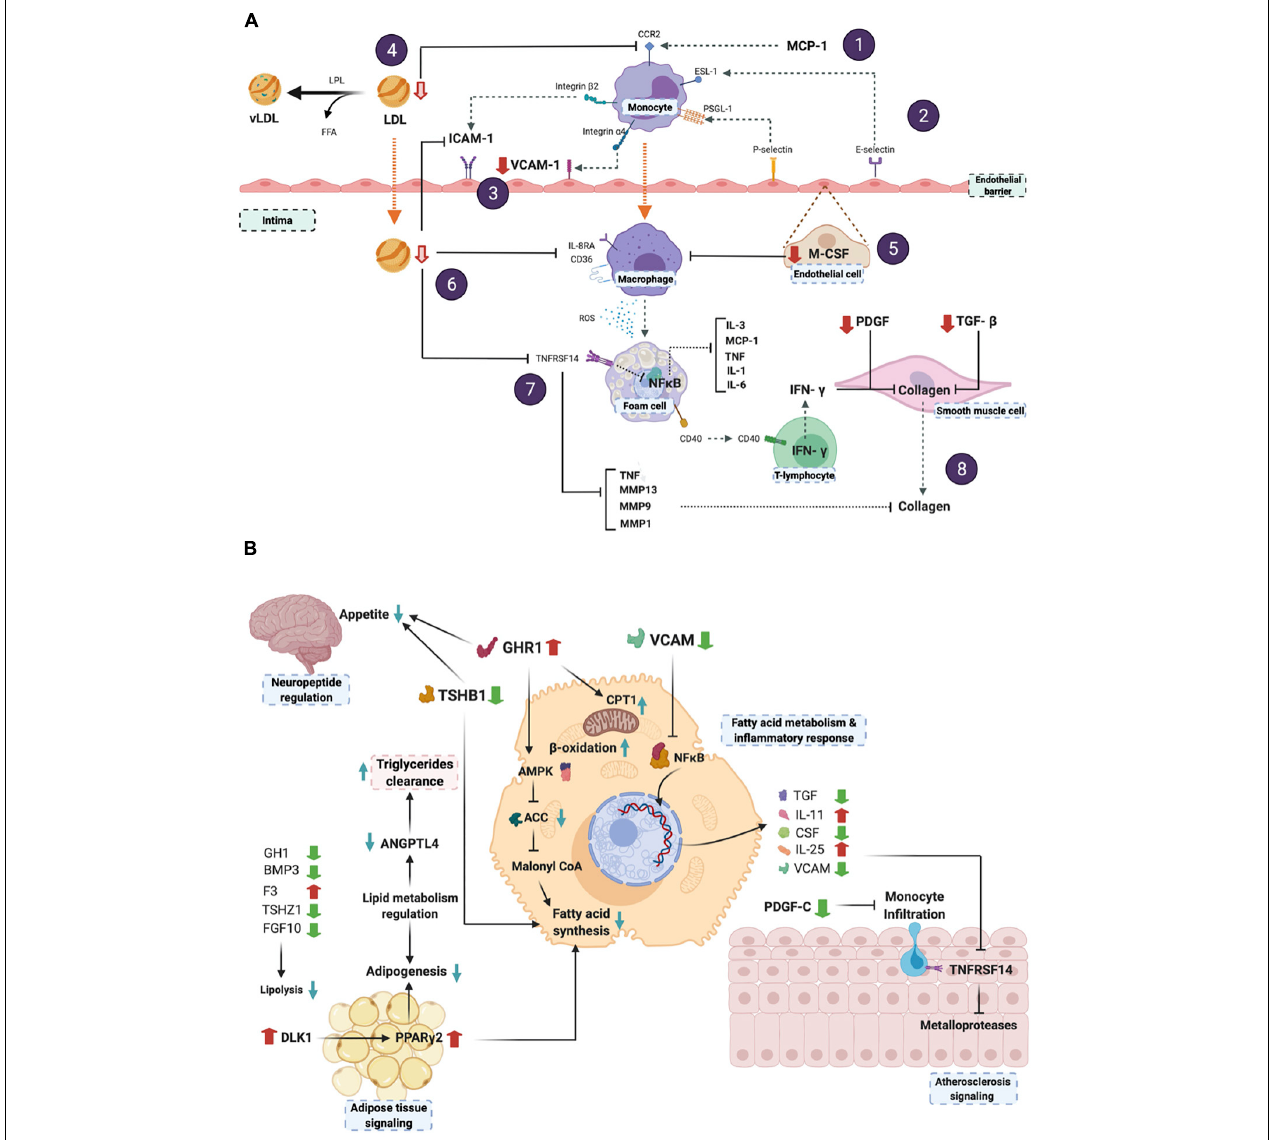
FIGURE 4 | (A) Predicted effects of BOSB consumption on atherosclerosis-related metabolic pathways; (B) Integration of the main BOSB-regulated systemic pathways associated to neuropeptide regulation, lipid metabolism and atherosclerosis signaling. This figure was generated with BioRender.com. (1) The atherosclerosis pathway initiates with LDL deposition and monocyte recruitment to the endothelial barrier mediated by MCP-1 and CCR2. (2) After monocyte rolling mediated by E-selectin and receptor ESL-1, (3) the lower levels of VCAM-1 found in the microarray analysis, and predicted reductions in plasma LDL levels, reduce endothelial cell adhesion. (4) Lower predicted LDL also inhibits CCR-2 expression and MCP-1 mediated trans endothelial migration of monocytes into the intima. It is known that ROS and oxidized-LDL uptake via scavenger receptors leads to lipid accumulation and foam cell formation that secrete a number of inflammatory cytokines. (5) Reduced M-CSF levels inhibit monocyte-to-macrophage differentiation, (6) as well as a decreased LDL migration into the intima and inhibition of CD36/IL-8RA. (7) This has a predicted effect on TNFRSF14 which may inhibit the NF-kB pathway and the downstream production of inflammatory cytokines (IL-3, MCP-1, TNF, IL-1, IL6), as well as TNF and matrix metalloproteases, involved also in inflammation processes and in atherosclerosis onset. (8) Finally, reduction observed for PDGF and TGF- β inhibits exacerbated collagen production via the CD40 receptor found in the surface of foam cells and T-lymphocytes, that may act via IFN- γ . Collagens constitute a component of the extracellular matrix in the atherosclerotic plaque.